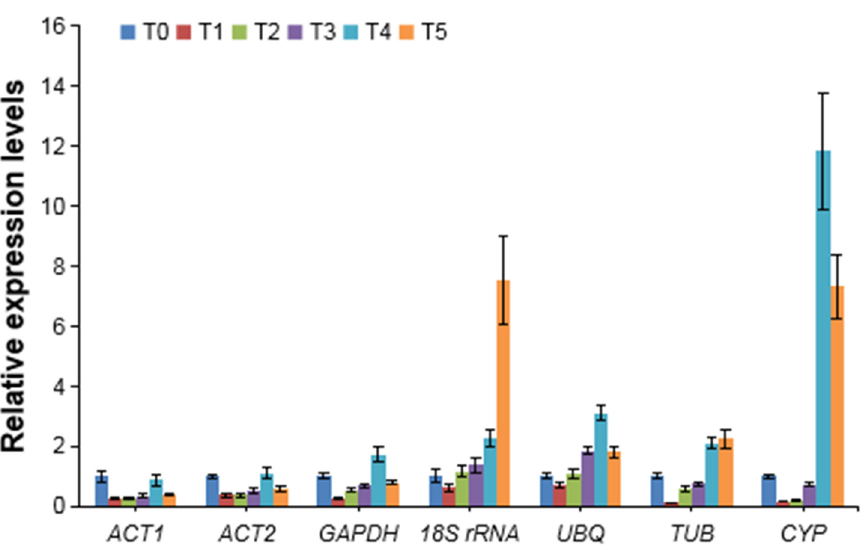
Figure 3. Relative expression levels of AcPSY normalized by the seven reference genes during fruit development. T0–T5 represent 30, 55, 70, 95, 130 and 145 days after 75% flower drop.